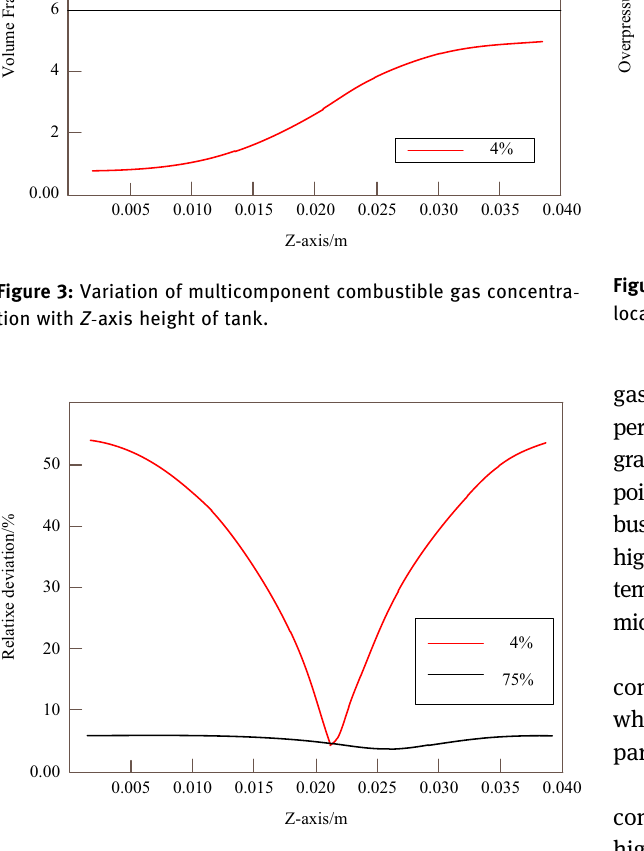
Figure 4: Variation of relative deviation of multicomponent com - bustible gas with Z - axis height of tank.